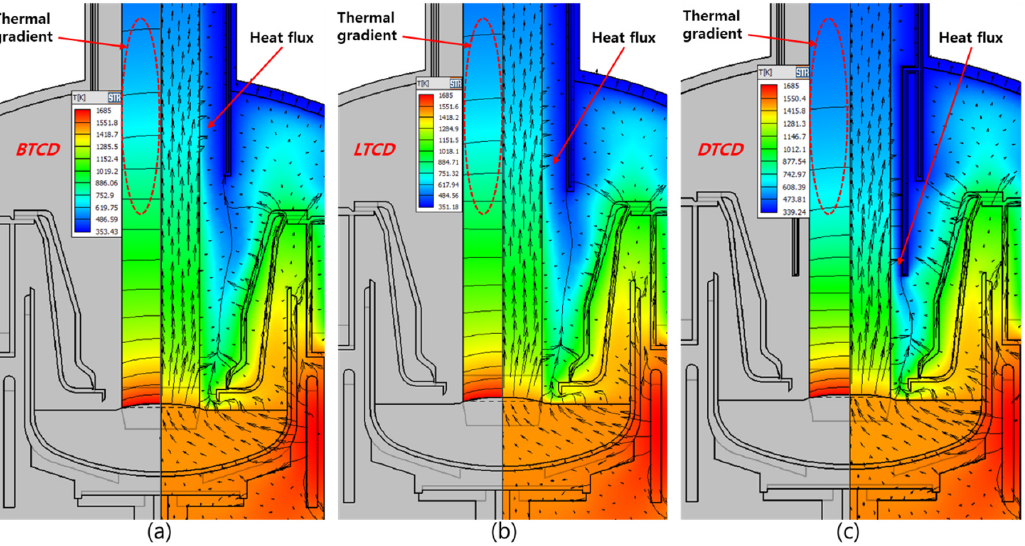
Figure 8. CG-Sim analyzed thermal gradient in crystal and the vectors indicated heat flux in Cz-process using BTCD ( a ), LTCD ( b ), and DTCD ( c ) cooling systems, respectively, at CP3000.